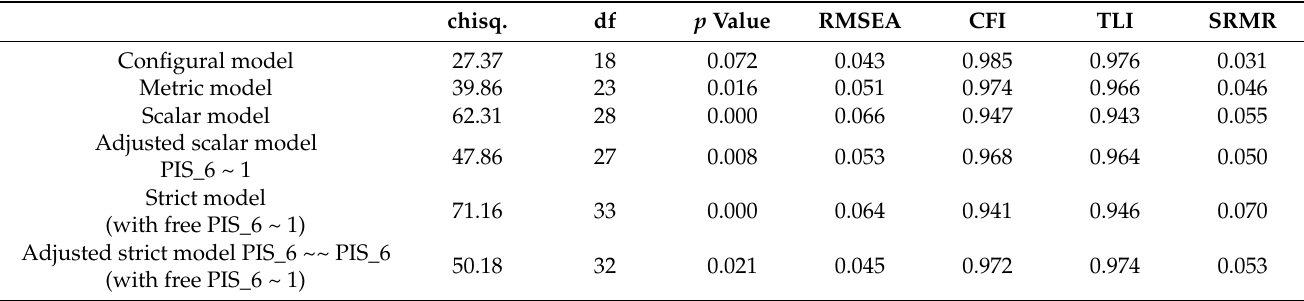
Table 4. Measurement invariance steps across religiosity groups.